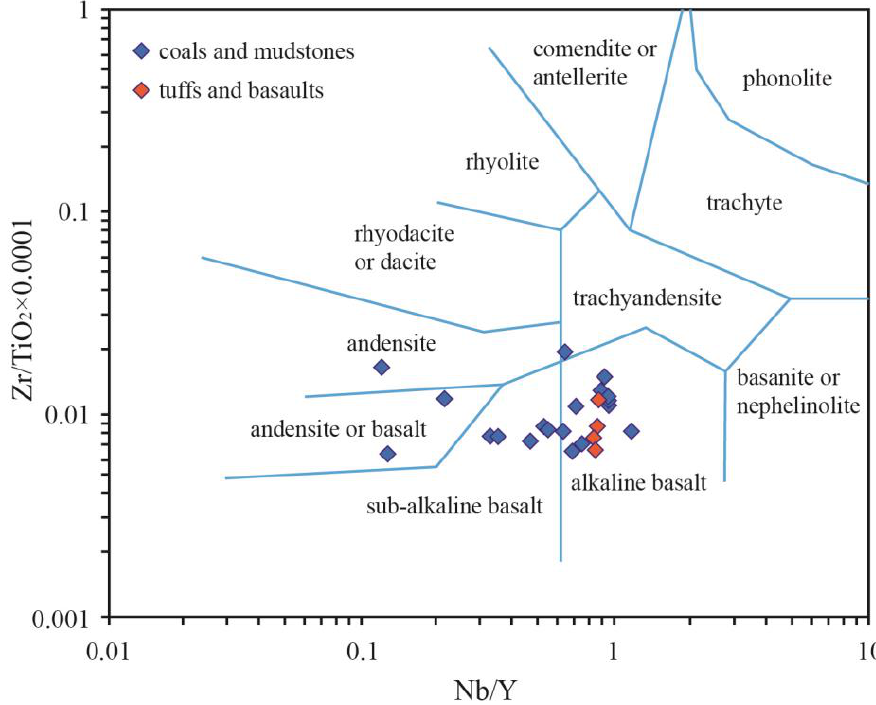
Figure 10. Distribution of Nb/Y and Zr/TiO 2 . Note: The blue spots are coal samples, parting samples, roof samples, and floor samples of the C4-Upper and C5 + 10 coal seams. The red spots are tuff and basalt samples from the floor of the C5 + 10 coal seam.